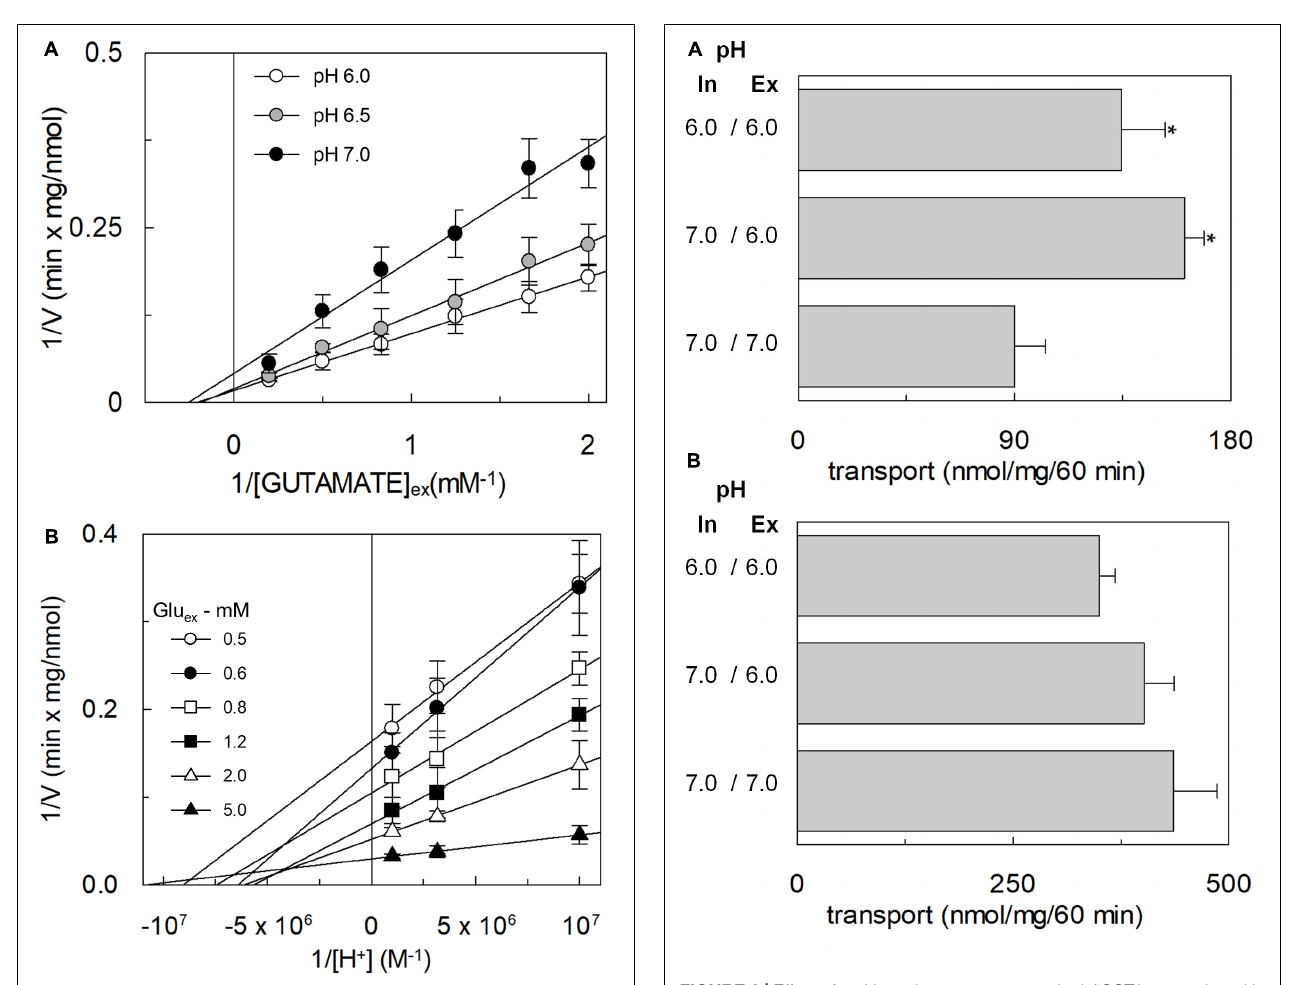
FIGURE 5 | Effect of pH on the kinetics of glutamate transport by hASCT2 reconstituted in proteoliposomes. Purified hASCT2 was reconstituted in proteoliposomes prepared at the indicated pH and containing 10 mM glutamine, as described in materials and methods. In (A) , the transport was started by adding indicated concentrations of [ 3 H]glutamate and 50 mM Na-gluconate to proteoliposomes buffered at different pH: pH 6.0 ( ◦ ), pH 6.5 ( • ), and pH 7 ( • ). The transport was measured in 15 min according to the stop inhibitor method. Data were plotted according to linear Lineweaver–Burk equation as reciprocal transport rate vs. reciprocal glutamate concentration. In (B) , data from Figure 5A were replotted according to Lineweaver-Burk equation as reciprocal transport rate vs. reciprocal proton concentration, performed at different glutamate concentration: 0.5 mM ( ◦ ), 0.6 mM ( • ), 0.8 mM ( (cid:3) ), 1.2 mM ( (cid:4) ), 2 mM ( (cid:52) ), and 5 mM ( (cid:78) ). The derived pKa values were as follows: 7.0 ± 0.2, 6.8 ± 0.2, 6.9 ± 0.2, 6.8 ± 0.2, 6.8 ± 0.2, 7.0 ± 0.2 at 0.5, 0.6, 0.8, 1.2, 2, and 5 mM glutamate, respectively. Results are means ± SD from five independent experiments.